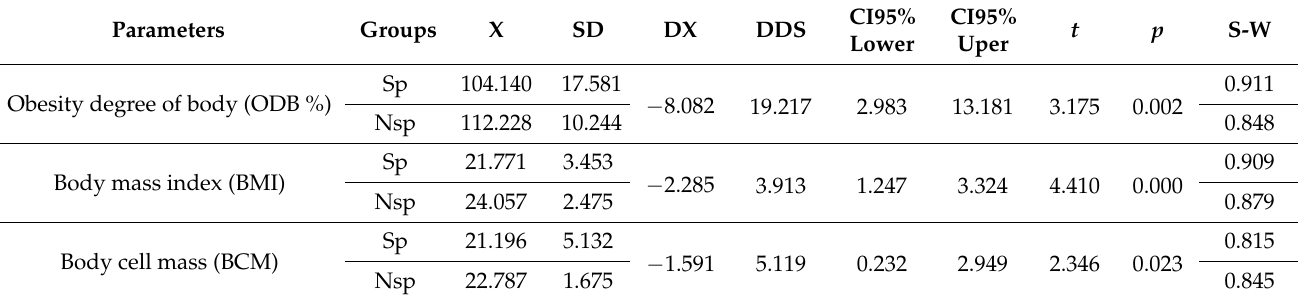
Table 6. Statistical analysis of the body composition parameters in female participants.